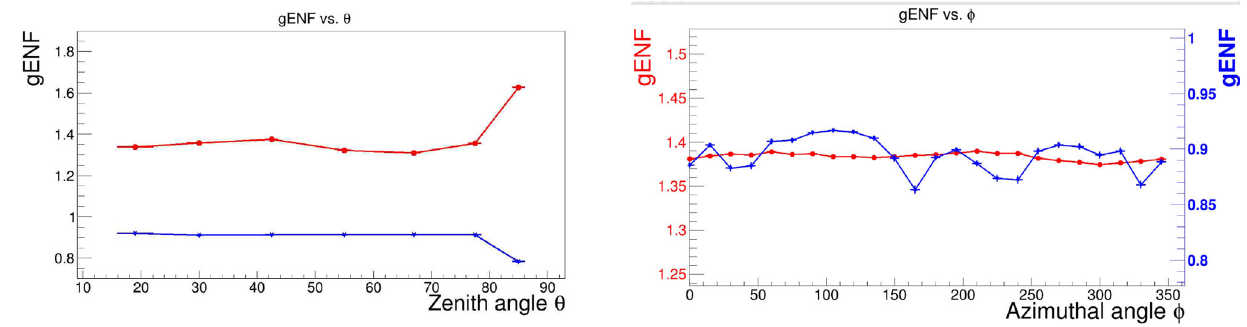
Fig. 35 Uniformity of gENF along the zenith angle ( θ , left) and azimuthal angle ( φ , right). HPK: blue; NNVT: red